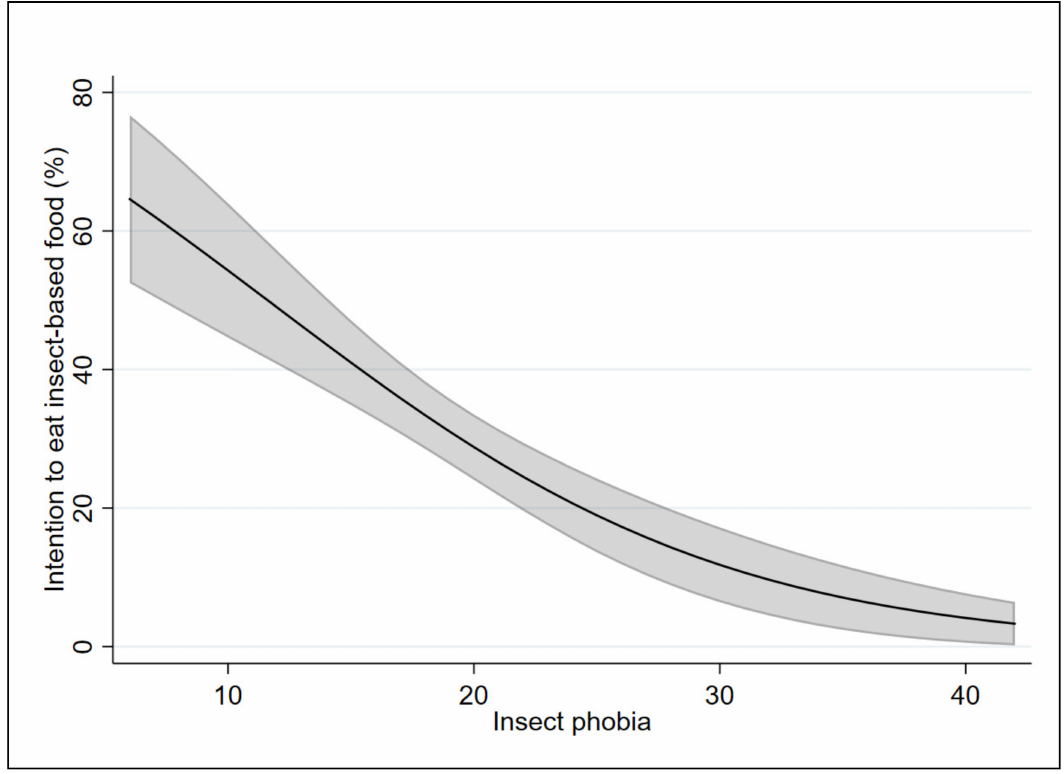
Figure 4. Marginal effects of the insect phobia scale on Model 2 with 95% confidence